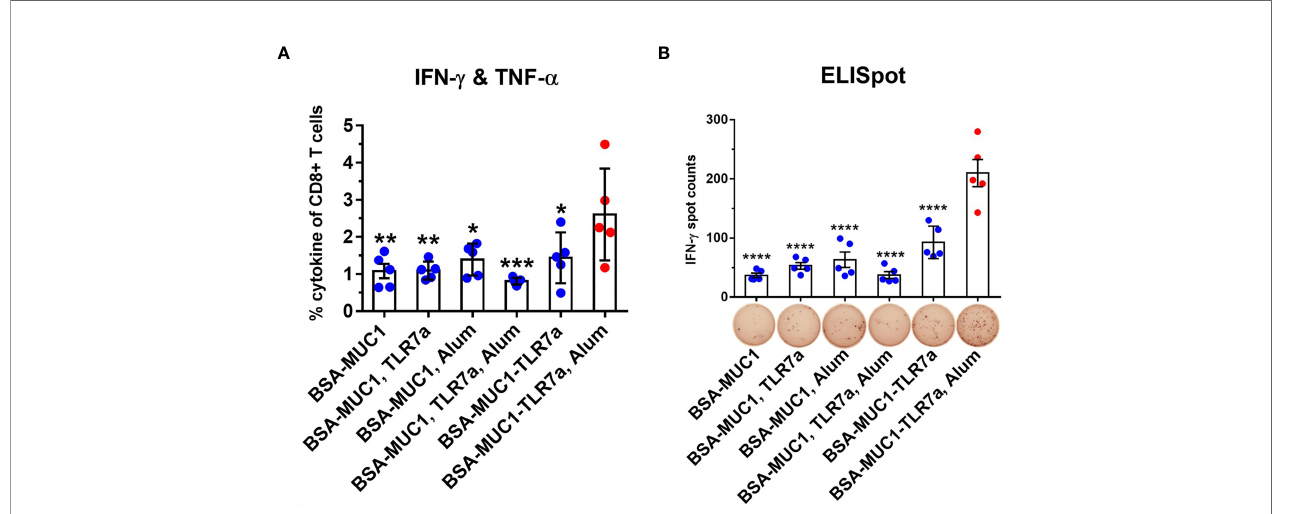
FIGURE 5 | Lymphocytes in the spleen (on day 42) were collected and stimulated with the MUC1 glycopeptide. Then the ICS assay (A) and ELISpot assay (B) were performed. The data are expressed as the mean ± SEM. Asterisks show signi fi cant difference compared with BSA-MUC1-TLR7a/Alum group based on one-way ANOVA by Dunn ’ s multiple comparison test (* p ≤ 0.05; ** p ≤ 0.01; *** p ≤ 0.001; **** p ≤ 0.0001).